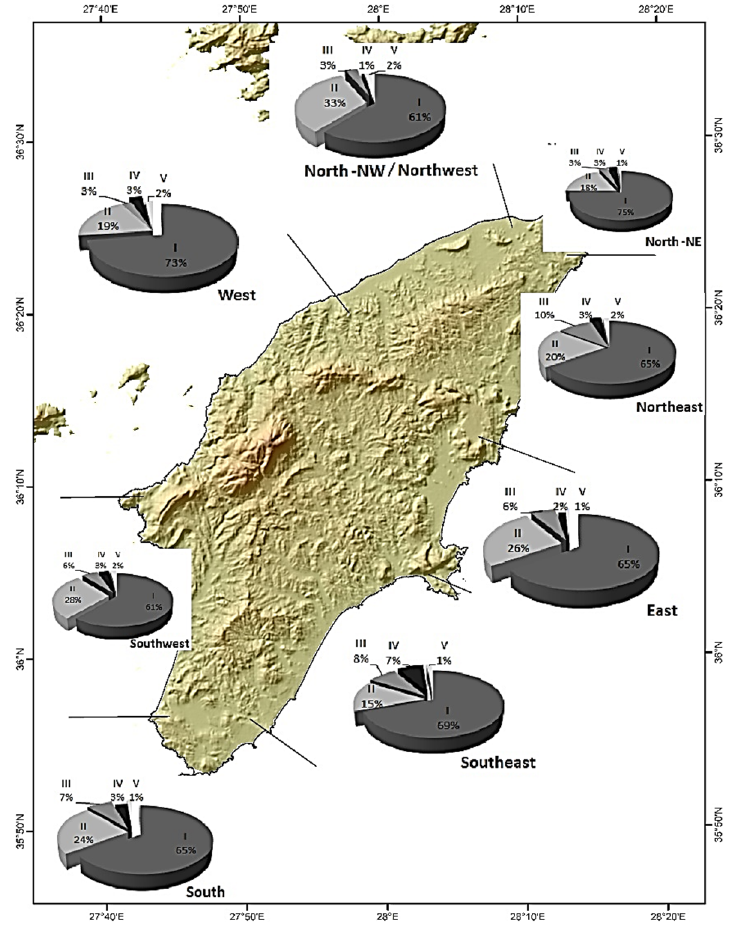
Figure 4. Frequency of occurrence of storm classes in each geographical region of the island.